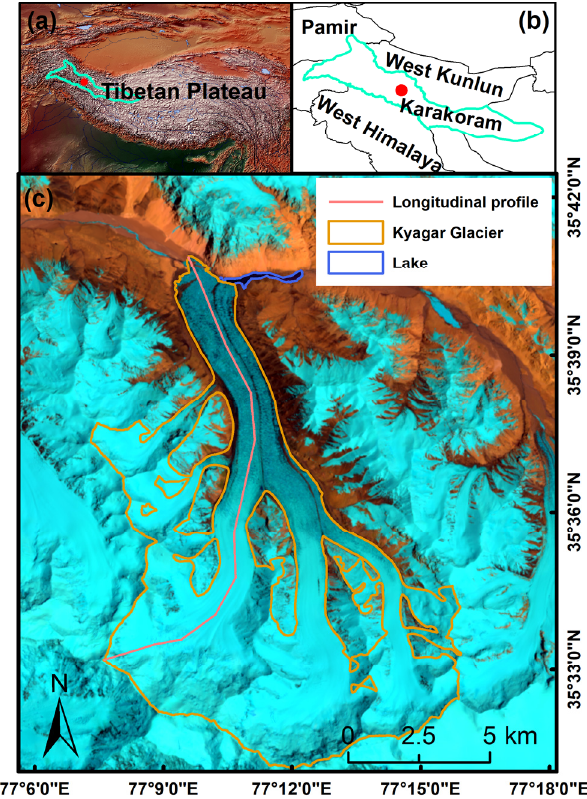
Figure 1. Kyagar Glacier. Location within the ( a ) Tibetan Plateau and ( b ) Karakoram Mountains. ( c ) Landsat image from 4 July 2015. The pink line indicates the position of a longitudinal profile used to analyze glacier velocity and elevation changes.